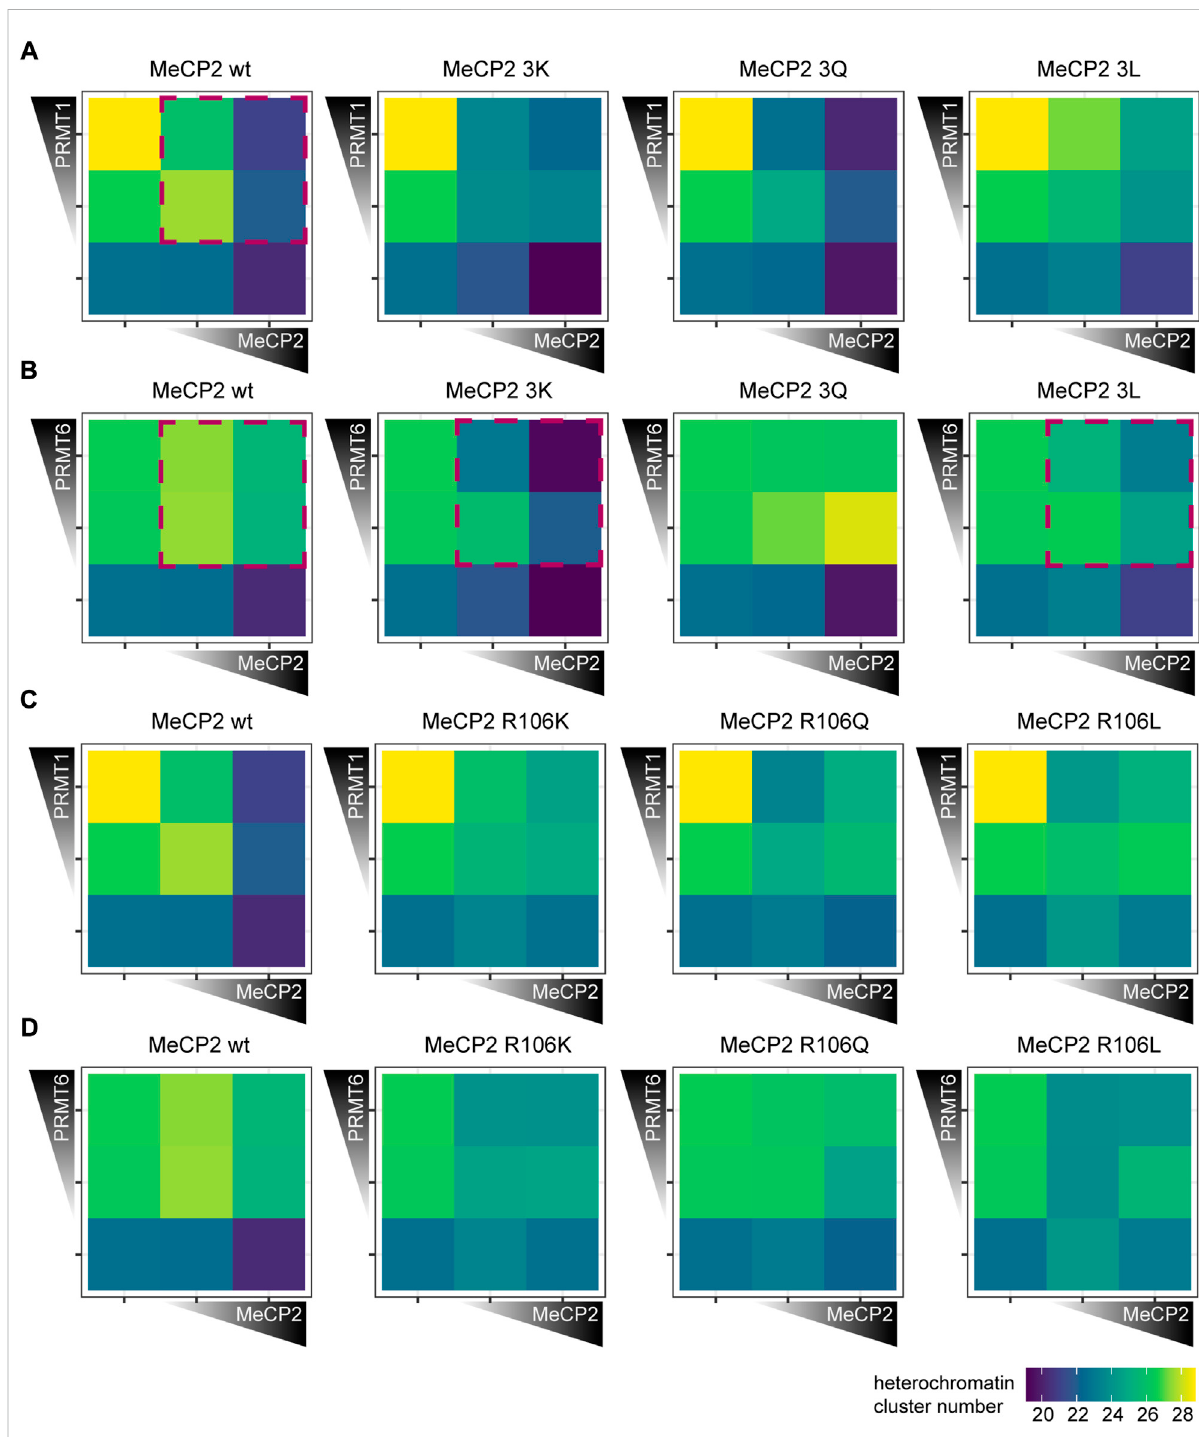
FIGURE 7 Heterochromatin clustering of cells transfected with MeCP2 mutant constructs inthe presence of protein arginine methyltransferases (PRMTs) 1 and 6. Heatmaps show the heterochromatin cluster numbers obtained by high-content screening microscopy of C2C12 cells cotransfected with MeCP2 wild type or triple mutants and PRMT1 (A) , wild type ortriplemutantsand PRMT6 (B) , wildtypeor R106 mutants and PRMT1 (C) and wild type or R106 mutants and PRMT6 (D) . Cells were binned for low and high fl uorescence intensity according to their MeCP2 and PRMT levels. Heterochromatin cluster numbers are shown as means of at least 26 cells from at least two biological replicates. The p -values representing the statistical signi fi cance calculated using Wilcoxon-Rank test are listed in Supplementary Table S6. Red boxes mark the most important